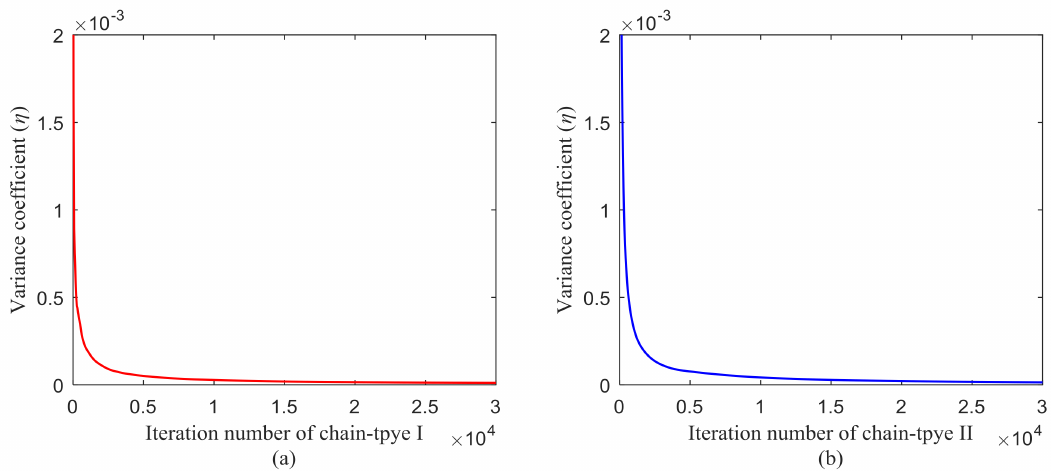
Figure 11. Variation process of the variance coefficient for ( a ) chain-type I and ( b ) chain-type